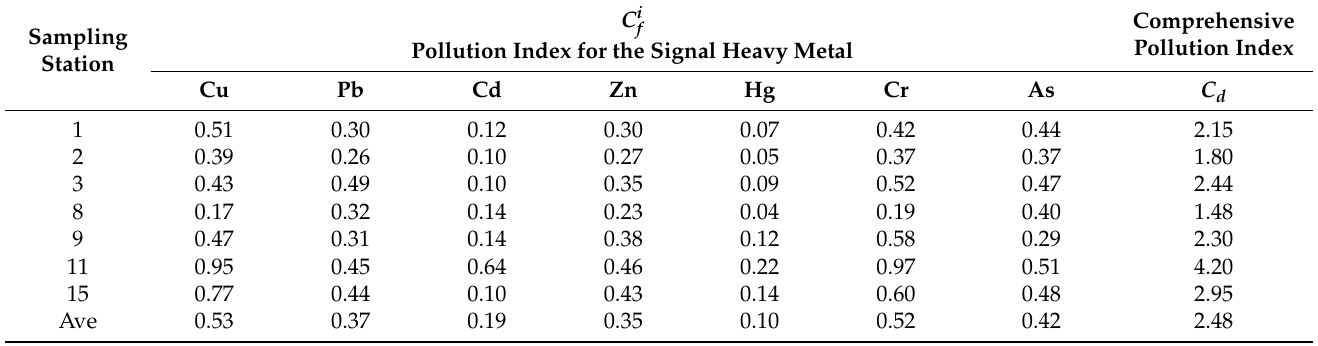
Figure 3. Spatial distribution of seven heavy metals in surface sediments.